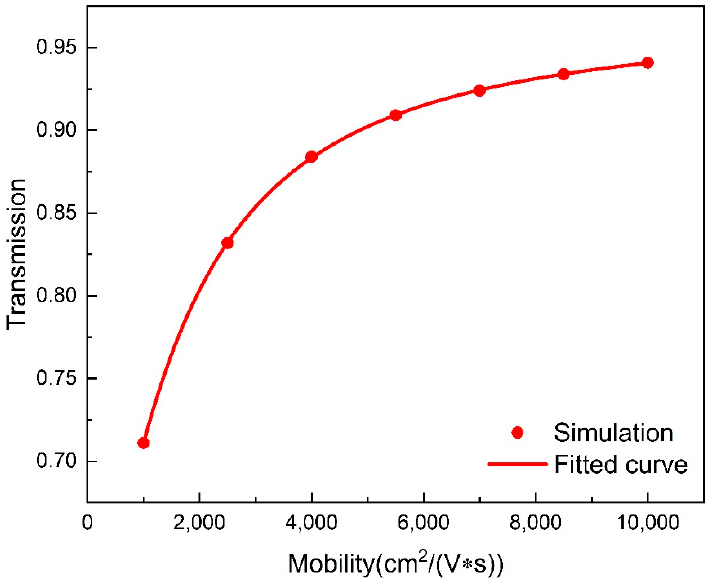
Figure 7. The transmission amplitude of the EIT peak varies with the mobility of graphene carriers (graphene Fermi level is 0.6 eV).